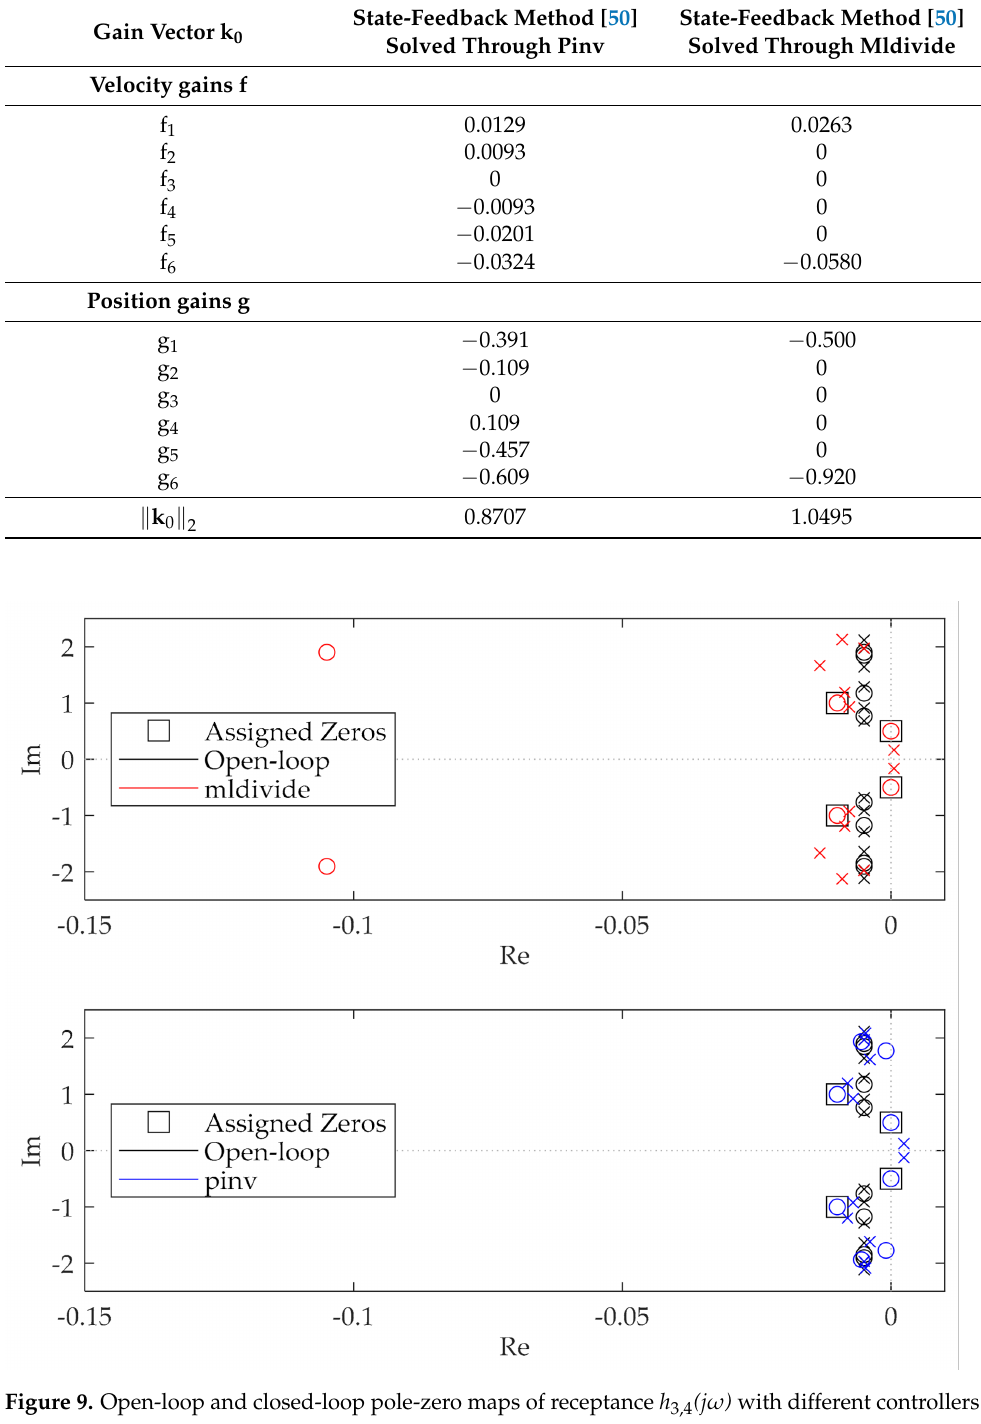
Table 9. Control gains in the numerical example of the assignment of zeros through the unit-rank active control for receptance h 3,4 (j ω ) .